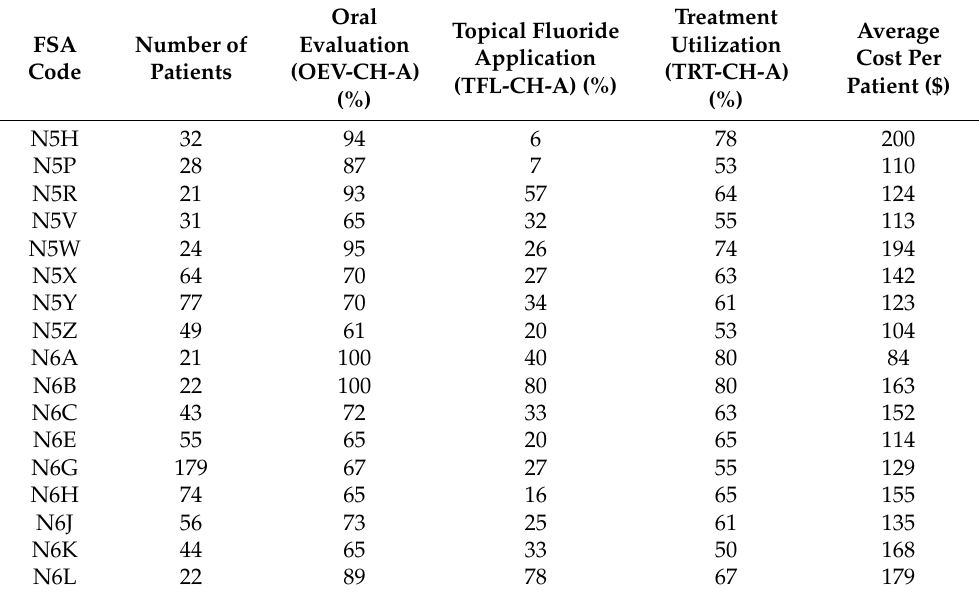
Table 1. Descriptive Statistics and DQA outcomes of the population.